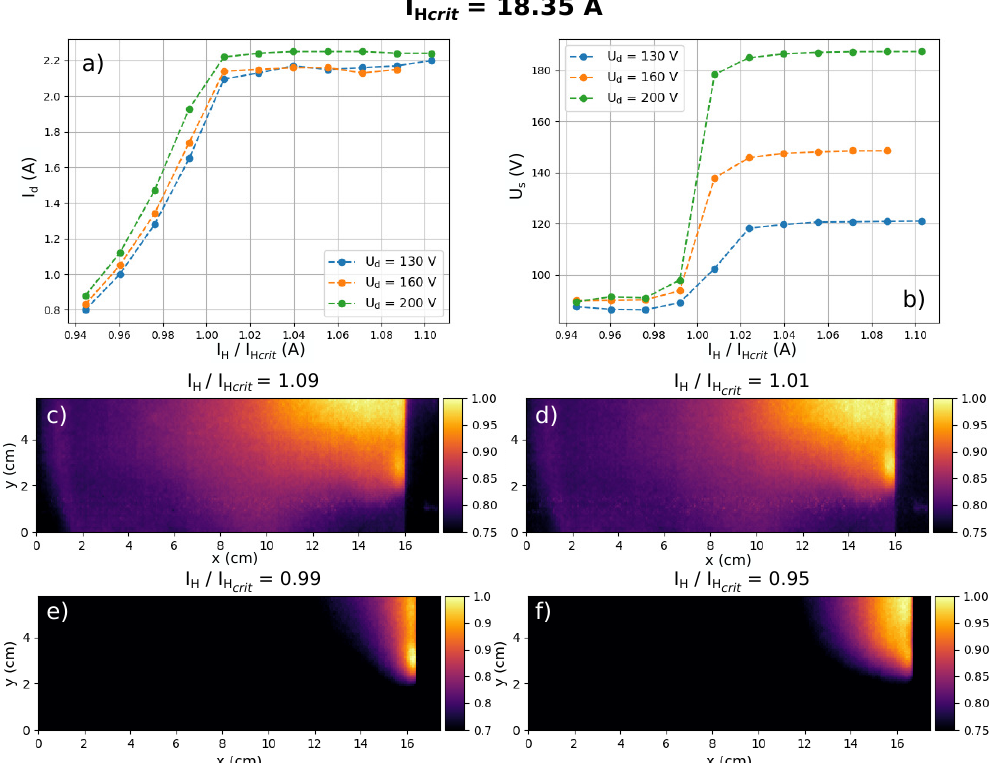
Figure 3. ( a ) Evolution of the HET discharge current I d depending on the cathode heating current I H for different discharge voltage U d . The heating current is normalised to the heating current at the regime transition I H , crit . ( b ) Evolution of the potential difference between anode and plume U s depending on the normalised cathode heating current for different discharge voltage U d . ( c – f ) The side view of the plume for different values of normalised cathode heating current. The other discharge parameters are Q = 1.8 mg · s − 1 and U d = 200 V. The light intensity has been normalised to each image